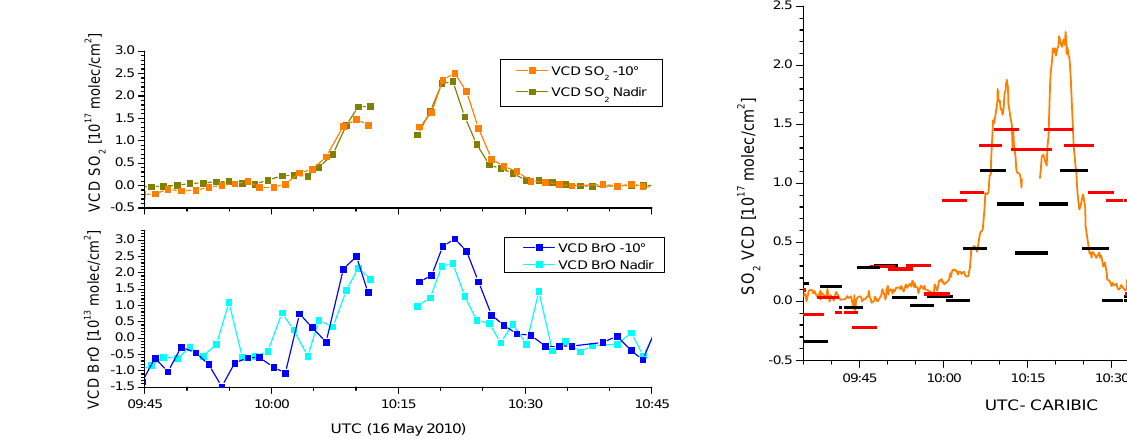
Fig. 11. Vertical column densities for CARIBIC DOAS nadir (brown, light blue) and − 10 ◦ (orange, dark blue), only the 80 sec averages are shown. The general agreement between the vertical column densities is good.